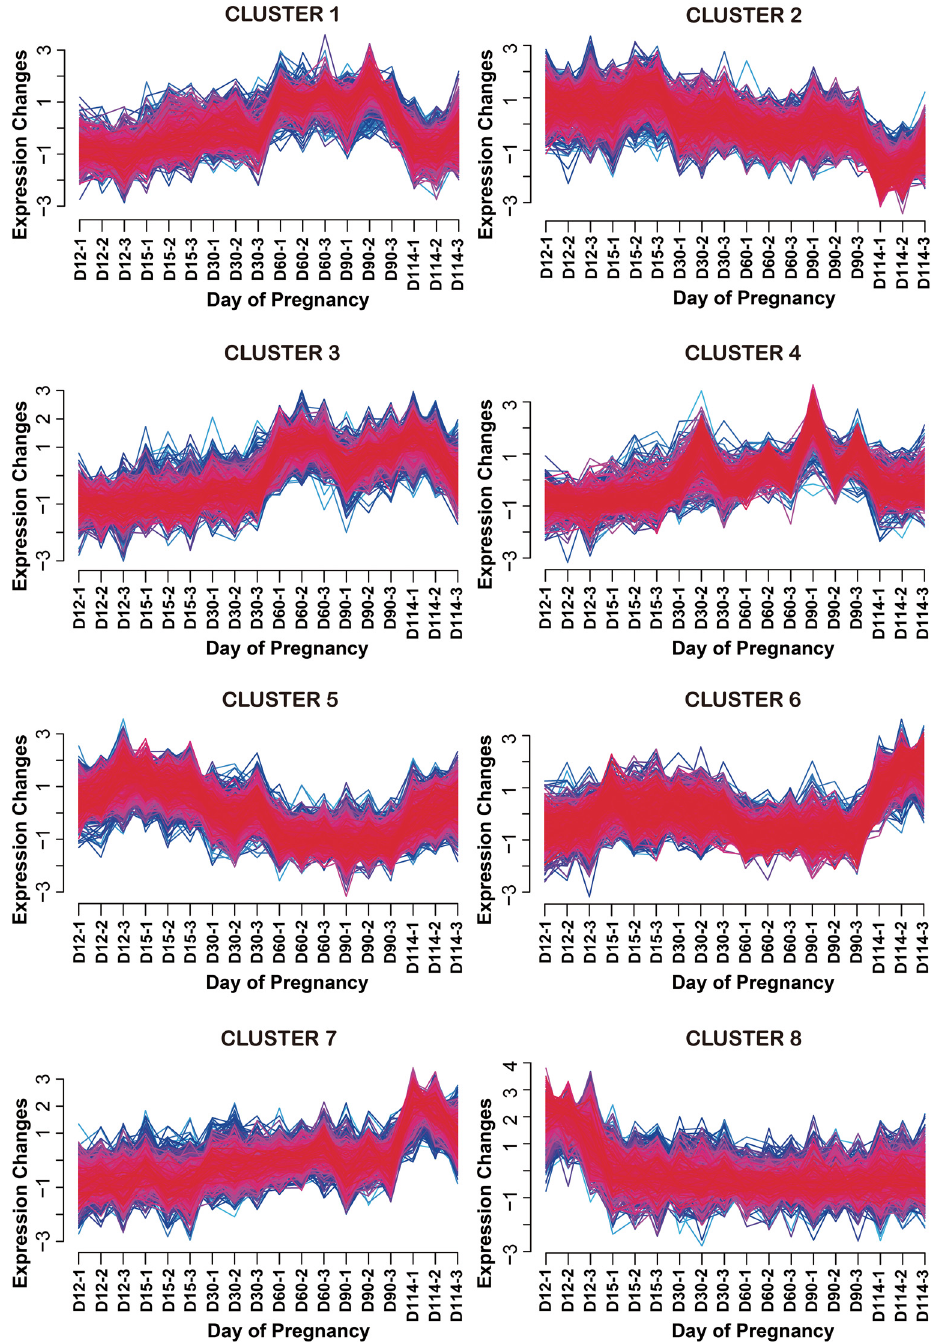
Fig 2. Clustering analysis of differentially expressed genes in the uterine endometrium during pregnancy in pigs. Clustering analysis was performed using the Mfuzz package and dendrograms of each cluster are depicted. The fuzzy c-means (FCM) clustering algorithm, which is a part of the package, uses a soft partitioning clustering method that requires two main parameters ( c = number of clusters, m = fuzzification parameter). In this analysis, the optimal values of c and m were derived by the iterative refinement procedure. Through this optimization, two parameters were calculated as c = 8 and m = 1.25. As a result, eight clusters were obtained. Yellow or green lines correspond to genes with a low membership value; red and purple lines correspond to genes with a high membership value. Most genes included in this figure showed a high membership